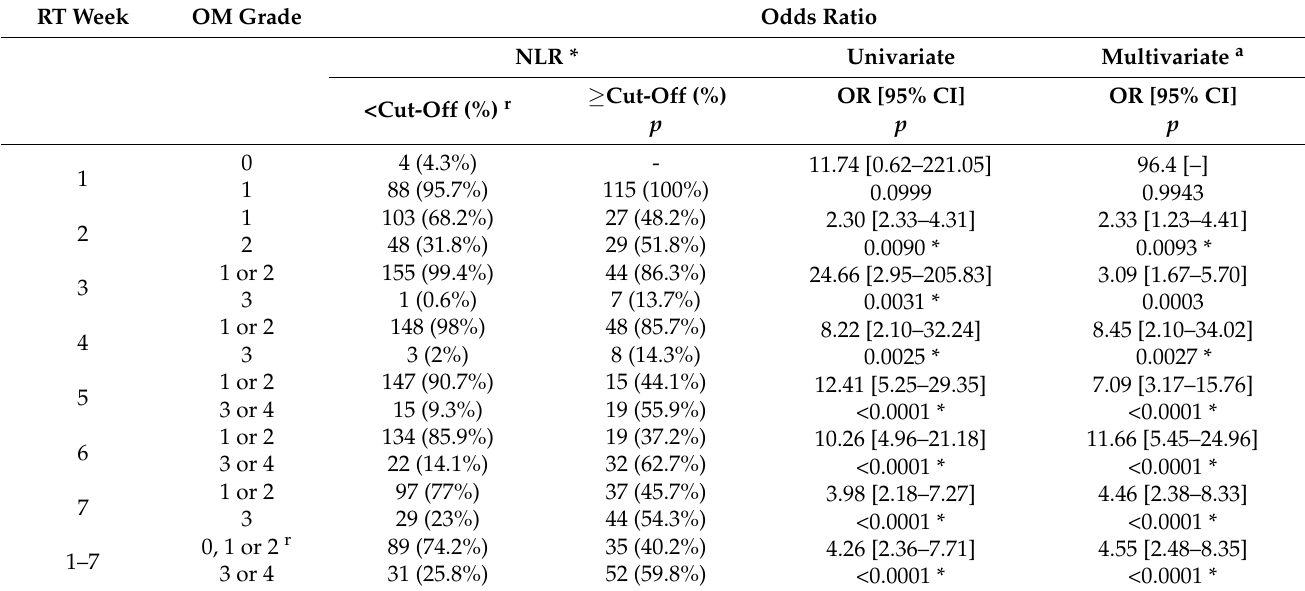
Table 3. The assessment risk of more severe OM after subsequent weeks of